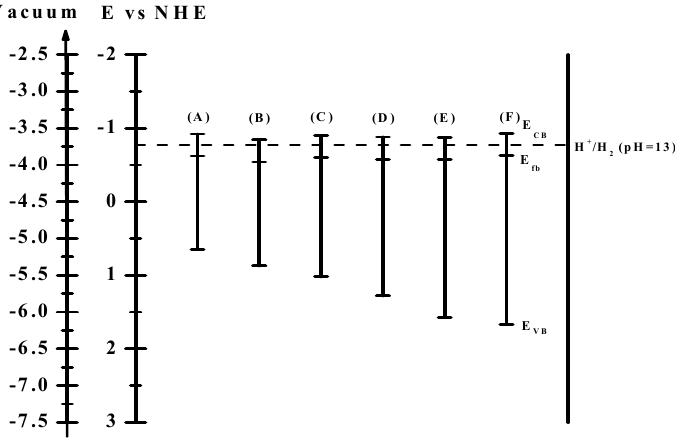
Figure 6. Band position of samples in the aqueous 0.25 M Na 2 S + 0.35 M K 2 SO 3 solution. The current density-applied voltage plots of samples A–F in the dark and under irradiation were employed to examine their PEC performances for hydrogen production. In order to compare with the PEC performances of metal sulfides reported in the literature [13,21,28,30], the aqueous 0.35 M Na 2 S + 0.25 M K 2 SO 3 solution was employed as the electrolyte. Figure 7 shows the typical current density-applied voltage measurements obtained using the chopping method for samples A–F with applied potentials in the range of − 1.0 V to 0.5 V vs. an Ag/AgCl electrode in the 0.25 M Na 2 S + 0.35 M K 2 SO 3 aqueous solution, respectively.